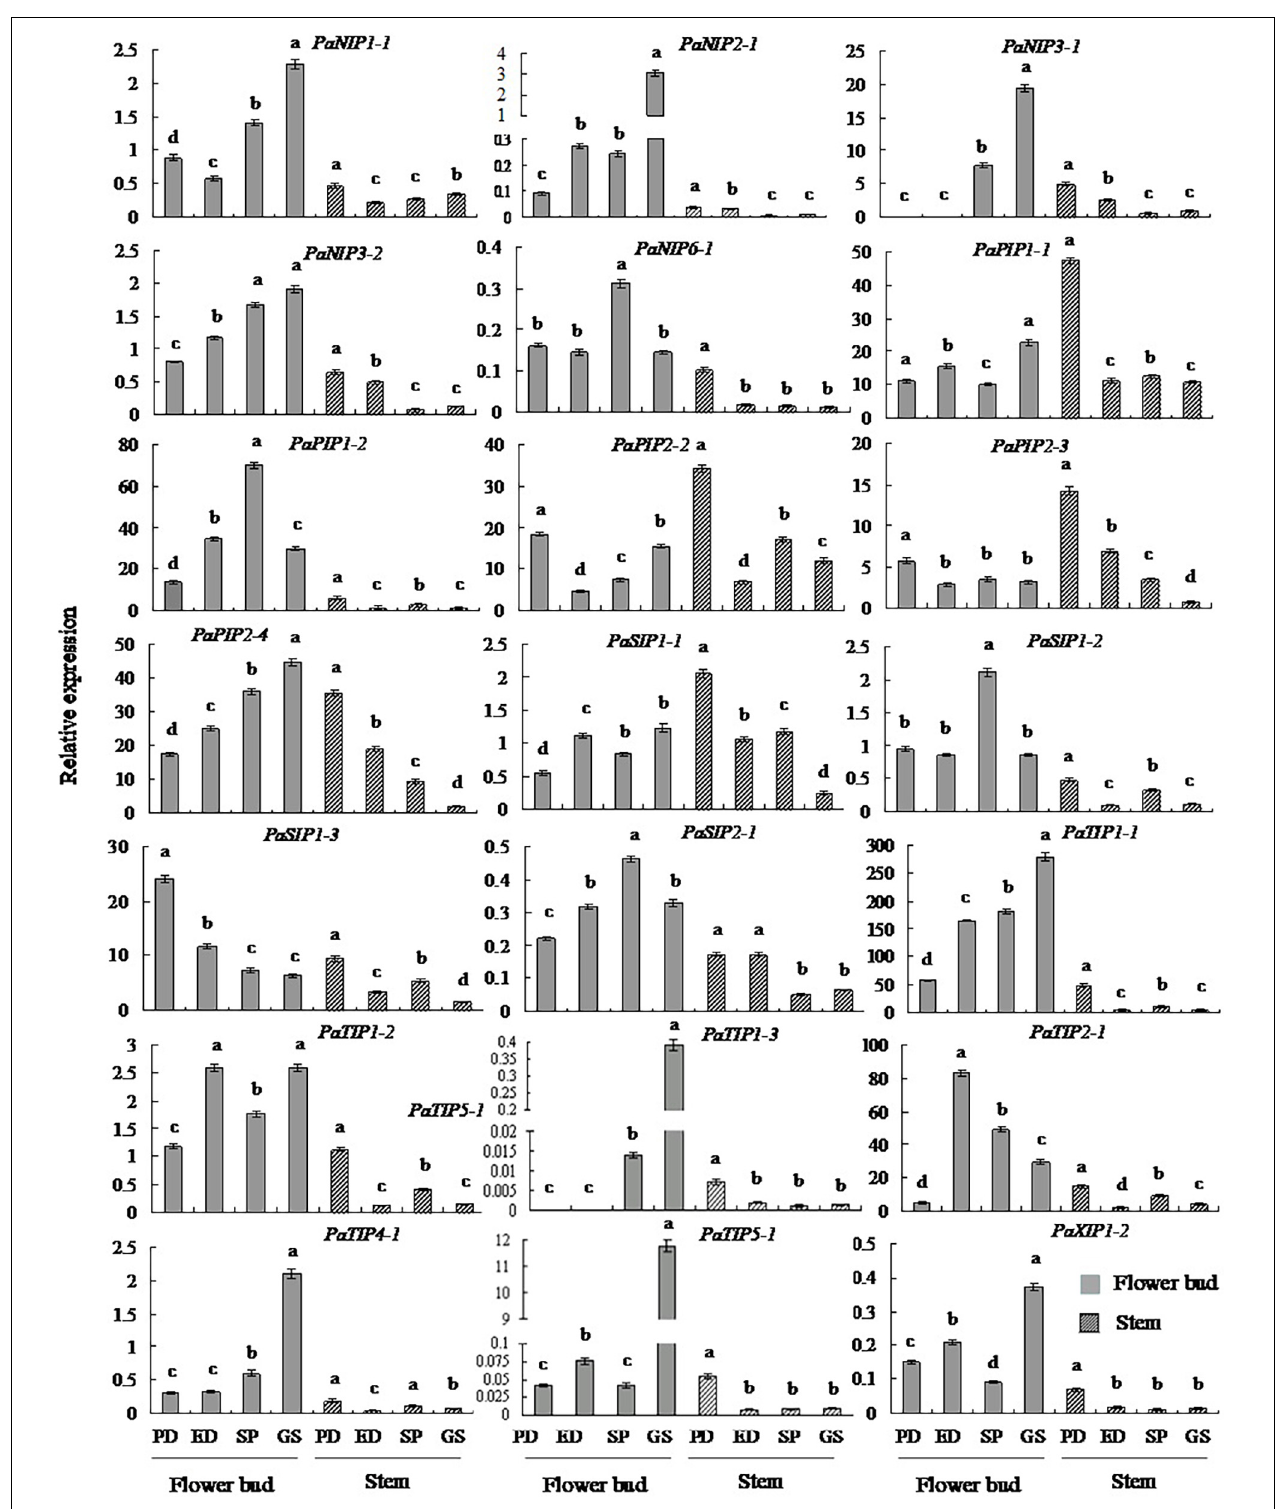
FIGURE 5 | Changes in the transcript levels of 20 selected genes in different tissues during the dormancy and sprouting stages of P. armeniaca . The stem and flower buds were collected during the PD stage, ED stage, SP stage, and GS stage of P. armeniaca plants. All expression levels of PaAQP genes were normalized to the expression levels of PaElf (elongation factor-1 α ). The 2 − (cid:49)(cid:49) CT method was used to analyze the relative gene expression. The data are means of three replicates ± SDs. The lowercase letters indicate statistical significance based on one-way ANOVA with Tukey’s HSD post hoc analysis.